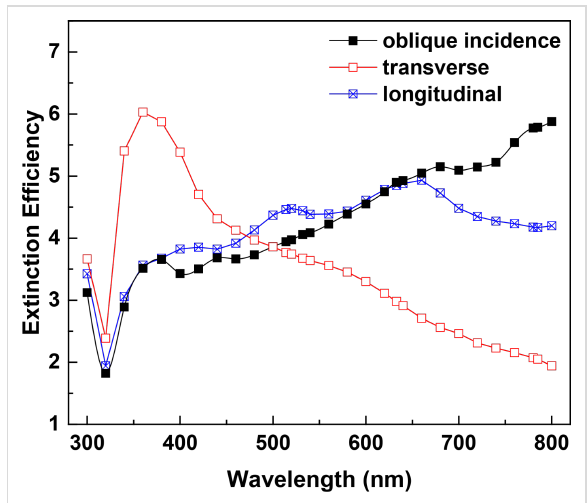
Figure 2: Extinction efficiency spectra of isolated S42 AgNR with AR = 3.5. The black curve corresponds to the situation in which the AgNR has a tilting angle of 42° and the propagation direction of the p-polarized light is parallel to the substrate surface normal. The red and blue curves represent the extinction efficiency of the target under the excitation of s-polarization and p-polarization, respectively, when the propagation direction of the light is perpendicular to the long axis of the